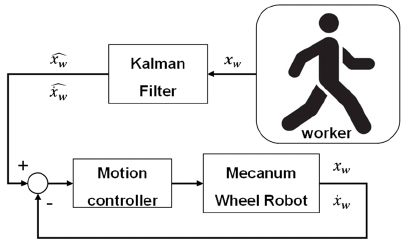
Figure 6. The control structure of a worker-following robot.